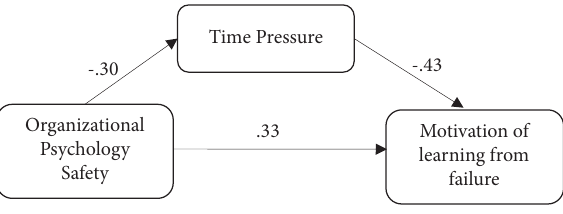
Figure 2: Path model for relations among the latent variables. Table 3: Descriptive statistics and correlation coefficient of